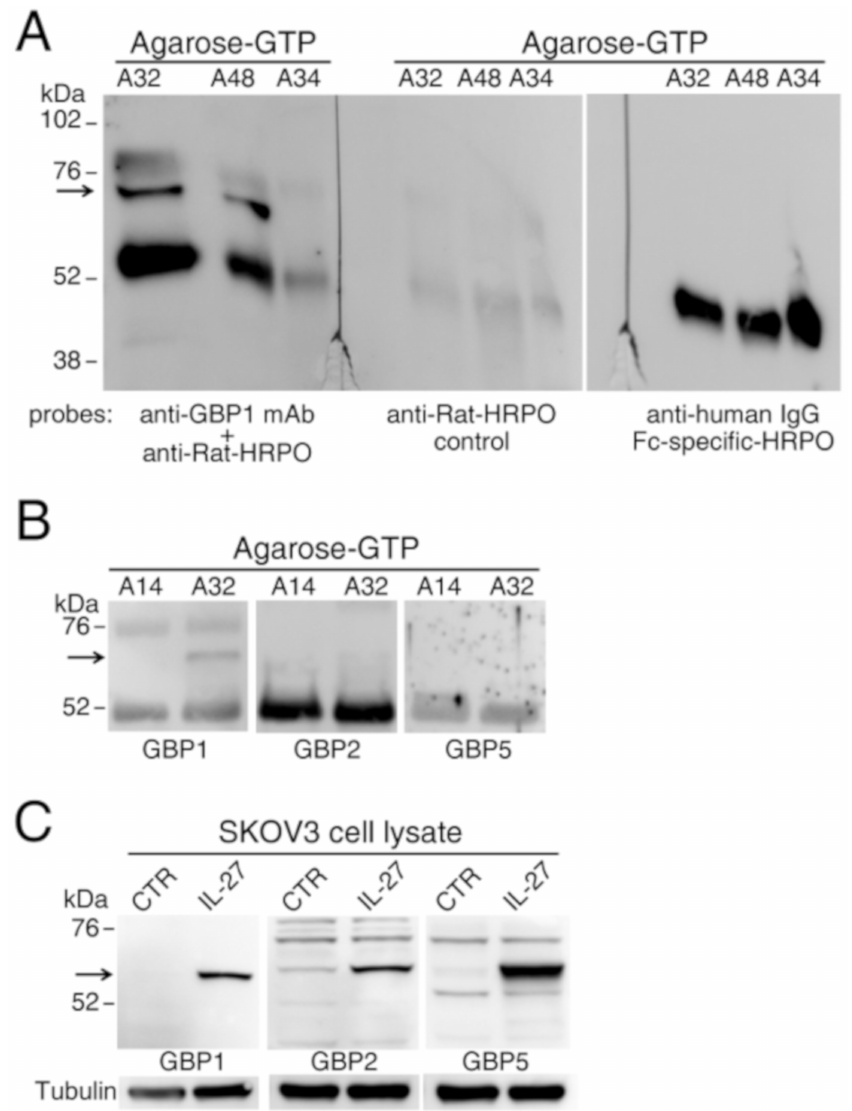
Figure 6. Enrichment of GBPs from EOC ascites by agarose-GTP beads shows the presence of soluble GBP1, whereas GBP2 and GBP5 were undetectable. ( A ) The 67 kDa GBP1 molecule (arrow, left panel) is detected by Western blot in proteins enriched by agarose-GTP beads precipitation from the ascites with high GBP1 ELISA levels. Center panel shows a parallel blot probed with secondary antibody only. The same blot was re-probed with an anti-human IgG Fc-specific antibody (right panel). ( B ) GBP2 and GBP5 were undetectable by Western blot of agarose-GTP-enriched ascites proteins, although ( C ) they were detected in cell lysates of IL-27-treated EOC cells, regarded as controls for antibody